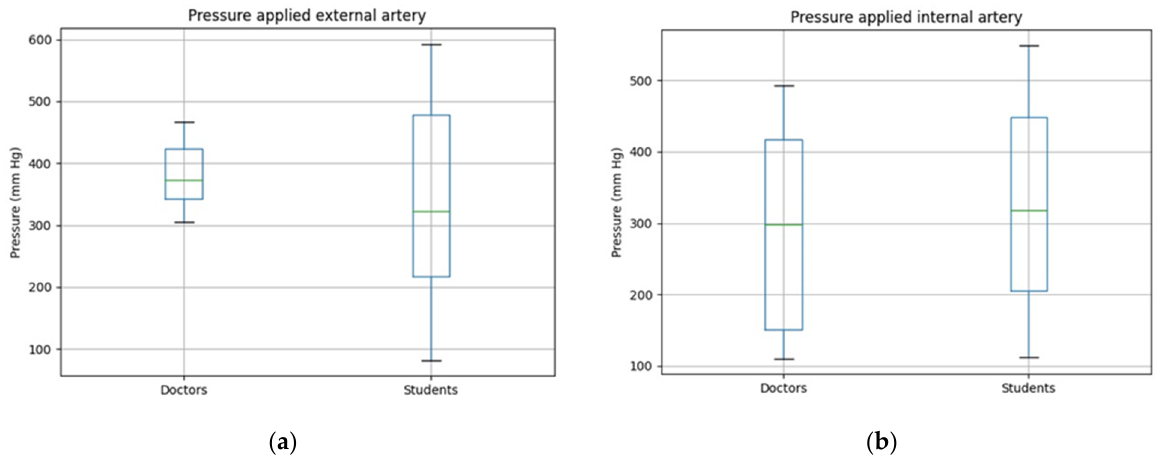
Figure 5. Pressure exerted to stop the bleeding by medical students and doctors if an arterial bleeding occurs in the lower limb. ( a ) Pressure exerted to stop an external arterial hemorrhage; ( b ) Pressure exerted to stop an internal arterial